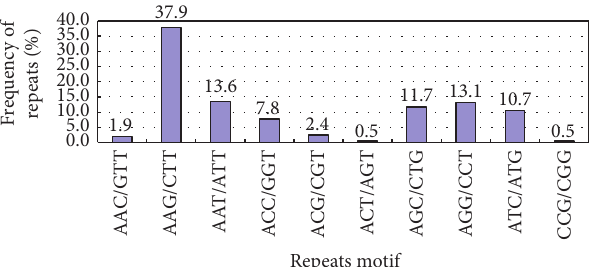
Figure 4: Trinucleotide repeats of